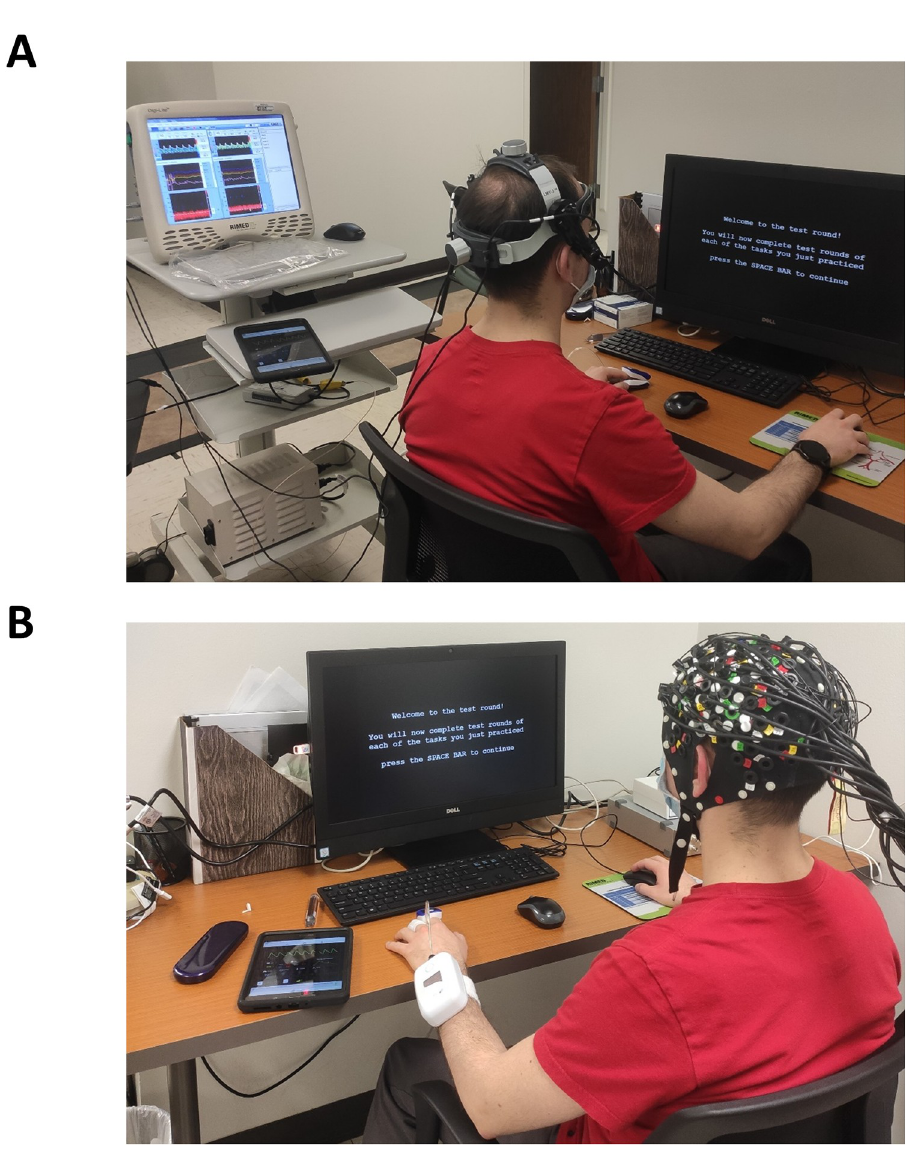
Fig 1. Experimental setup. Participants were seated in front of the computer that delivered the cognitive paradigm. Changes in cerebral hemodynamics were recording during cognitive stimulation with transcranial Doppler sonography (Panel A) and functional near-infrared spectroscopy (Panel